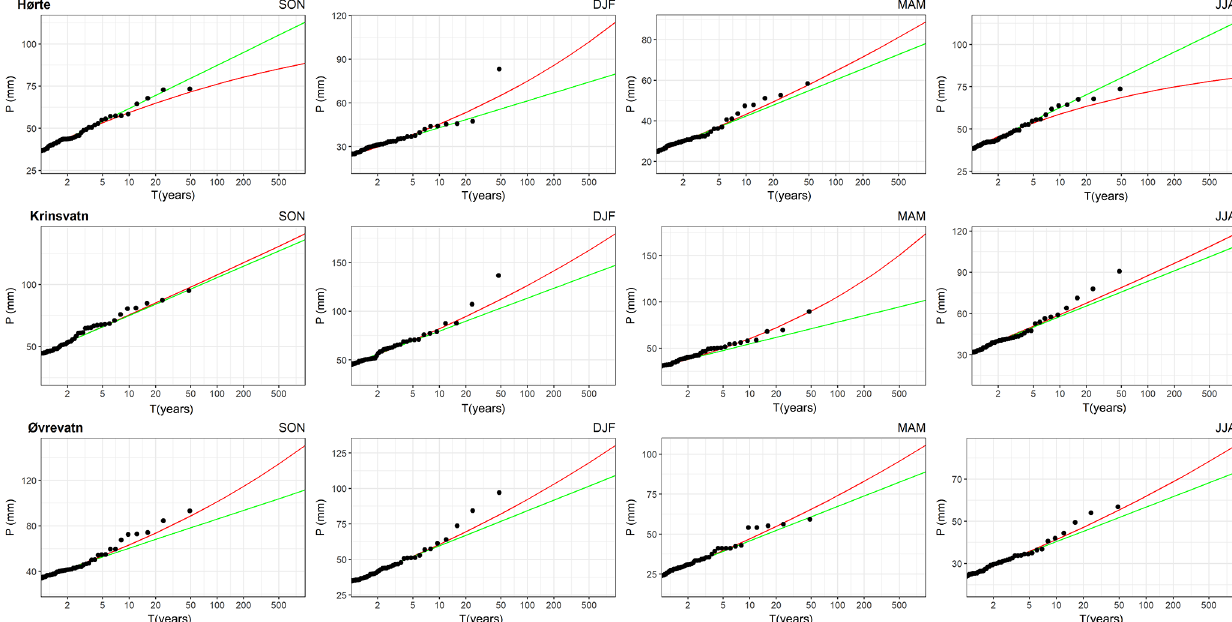
Figure 4. Return level plots for the fitted generalized Pareto (GP) and exponential (EXP) distributions for peak-over-threshold precipitation events with duration equal to the critical duration (GP, red; EXP, green) for the three selected